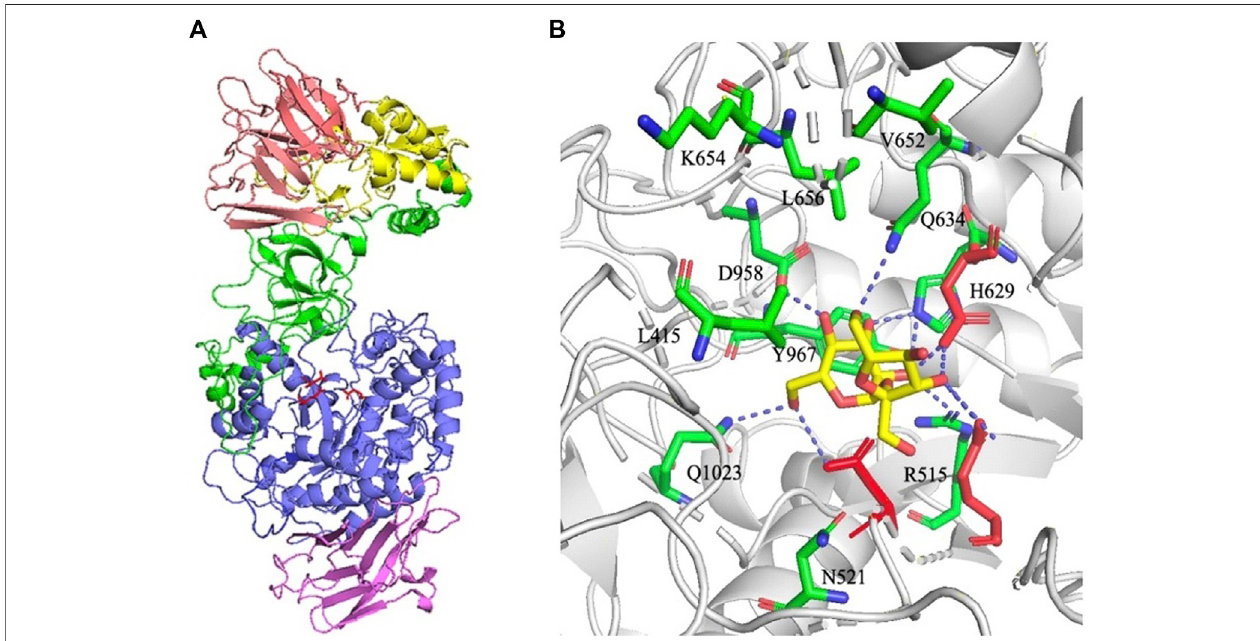
FIGURE1|(A) Structural organizationofDSR-M Δ 2(PDBentry:5LFC).DomainsA,B,C,4,and 5arecoloredinblue,green, purple,yellow,andpink, respectively. CatalyticresiduesAsp517(nucleophile),Glu555(acid/base),andAsp630(transitionstatestabilizer)areshownwithredsticks. (B) StructureofDSR-M Δ 2incomplexwith sucrose visualized through the software PyMol ™ 2.2.0. Eleven amino acids within a 5-angstroms distance from sucrose are marked in green sticks. Catalytic residues Asp517, Glu555 and Asp630 are shown with red sticks, and substrate sucrose was shown with yellow sticks. Hydrogen bonding interactions are shown as blue dashed